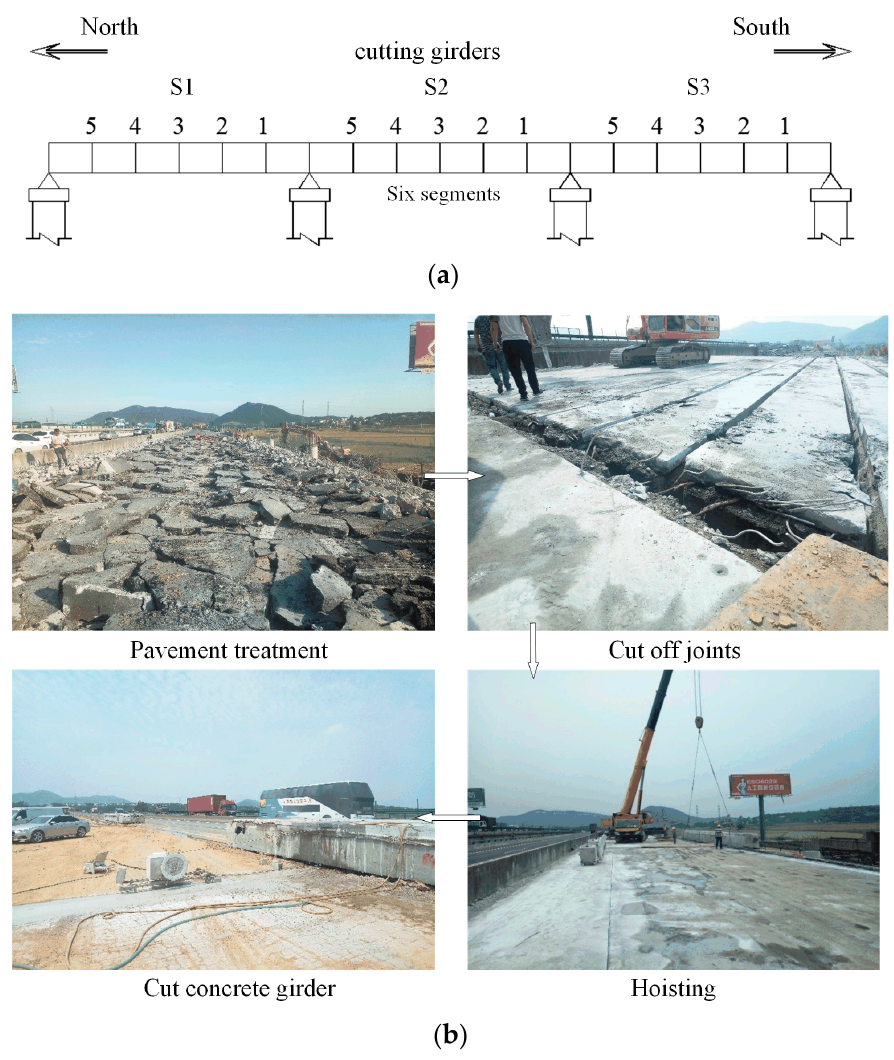
Figure 4. Process of cu tt ing the concrete girders: ( a ) plan for cu tt ing girders; ( b ) cu tt ing test.